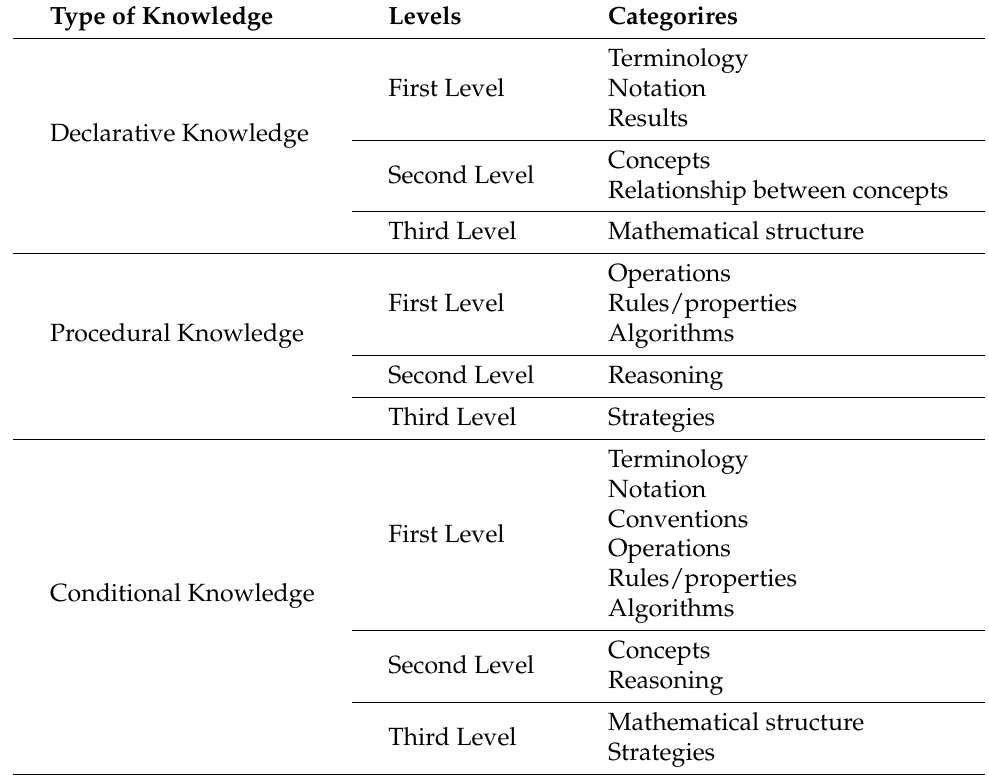
Table 2. Reach and development levels